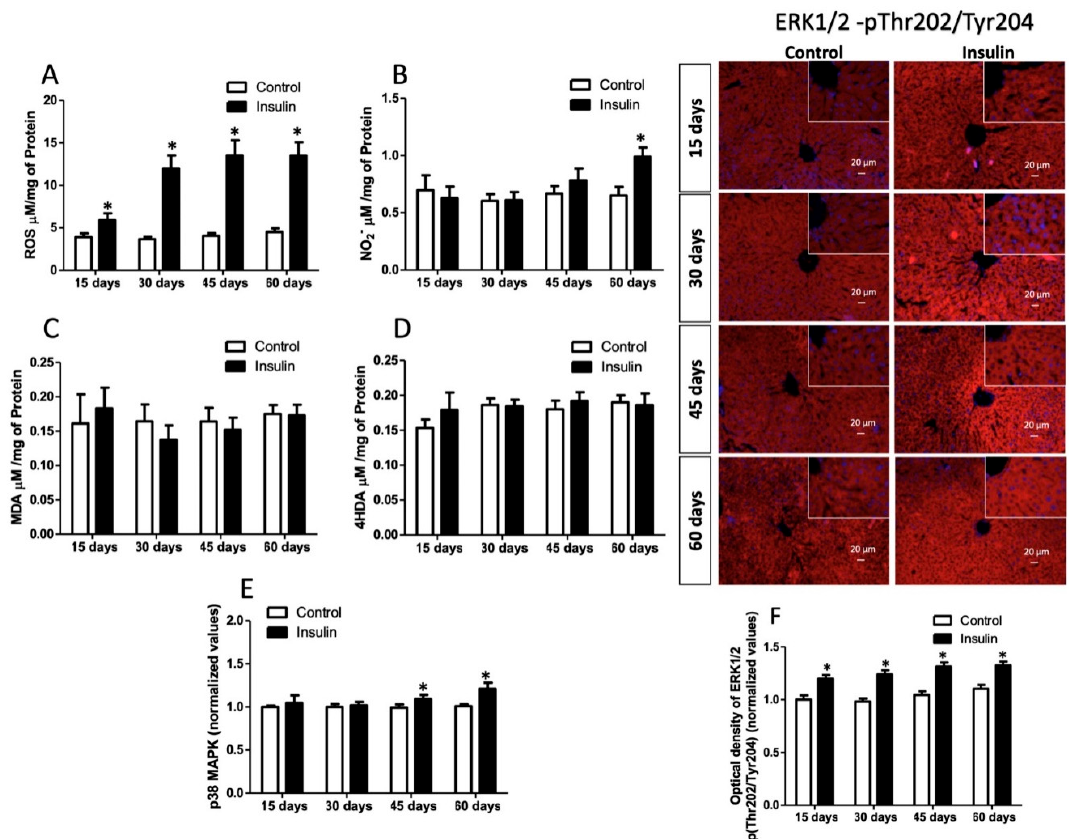
Figure 5. Hepatic oxidative stress and MAPK response. ( A ) Reactive oxygen species (ROS); ( B ) nitrites (NO 2 − ); ( C ) malondialdehyde (MDA); ( D ) 4-hydroxyalkenal (4HDA); ( E ) p38-MAPK level; ( F ) ERK1/2-MAPK immunoreactivity. (*) indicates a significant difference compared to the control